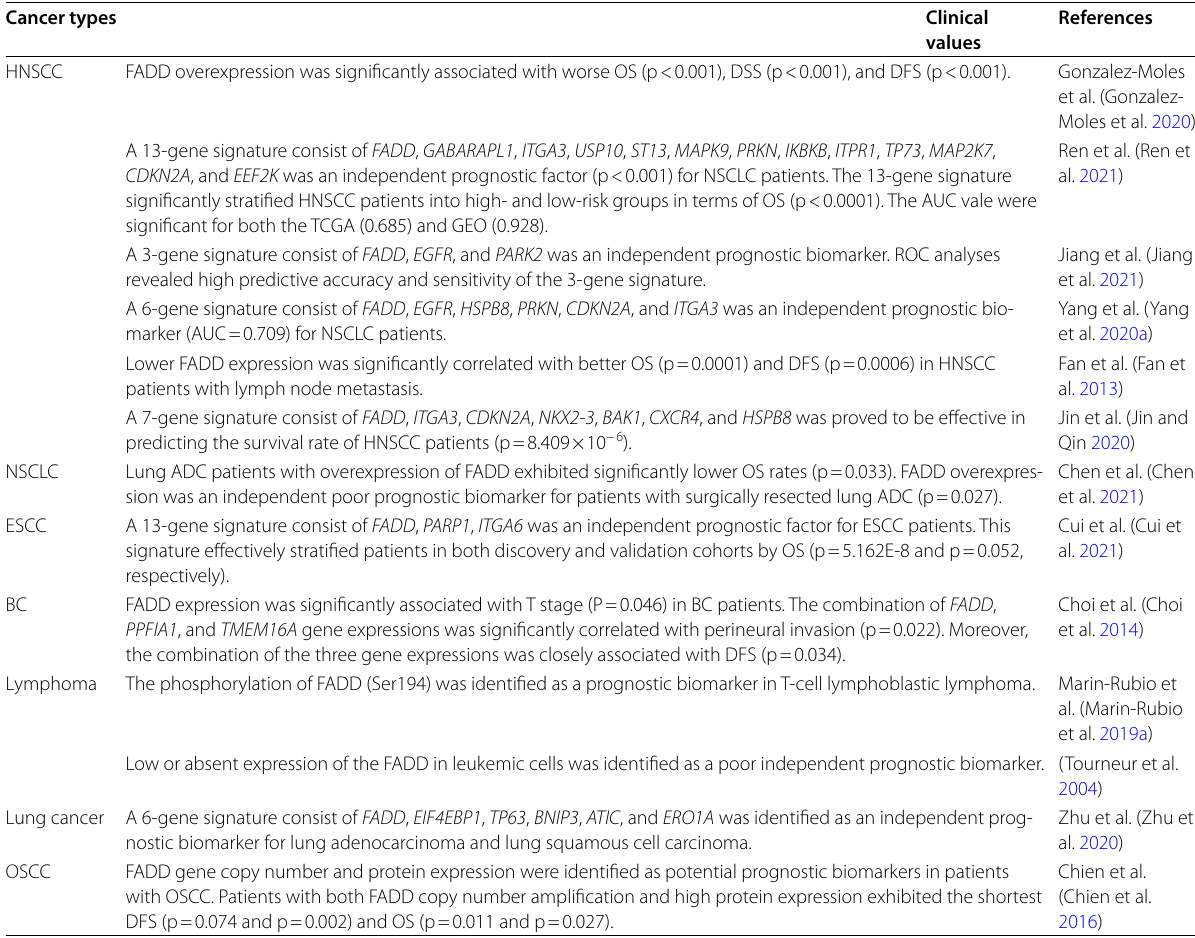
Table 3 FADD as a prognostic biomarker in